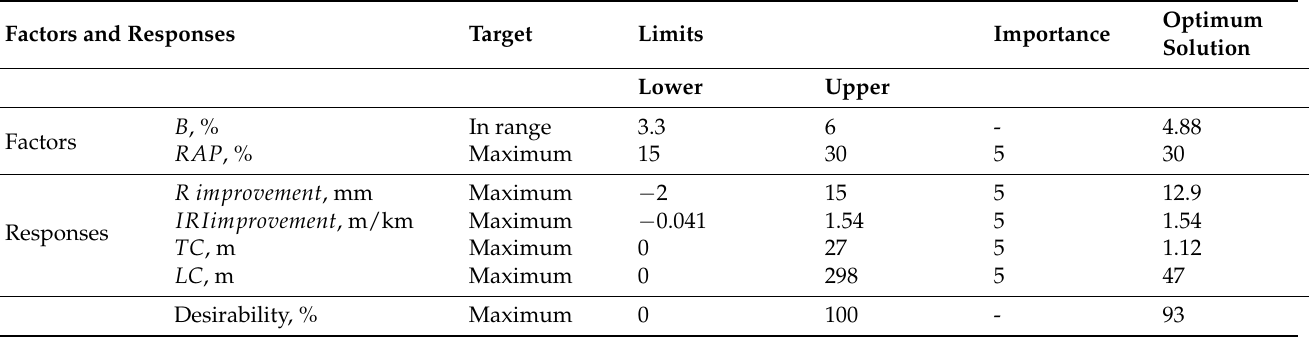
Figure 13. Response surfaces for WMA overlay containing RAP in wet conditions. Table 4. Optimal solution for WMA mixture containing RAP for use in dry